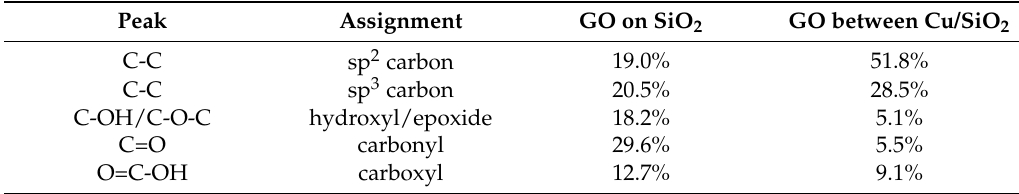
Table 1. The calculated proportion of C-containing components of the C1s spectra.